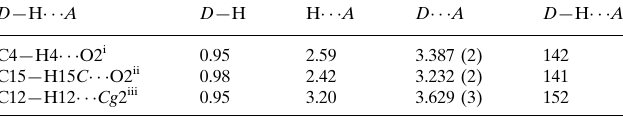
Hydrogen-bond geometry (A˚ , (cid:1)